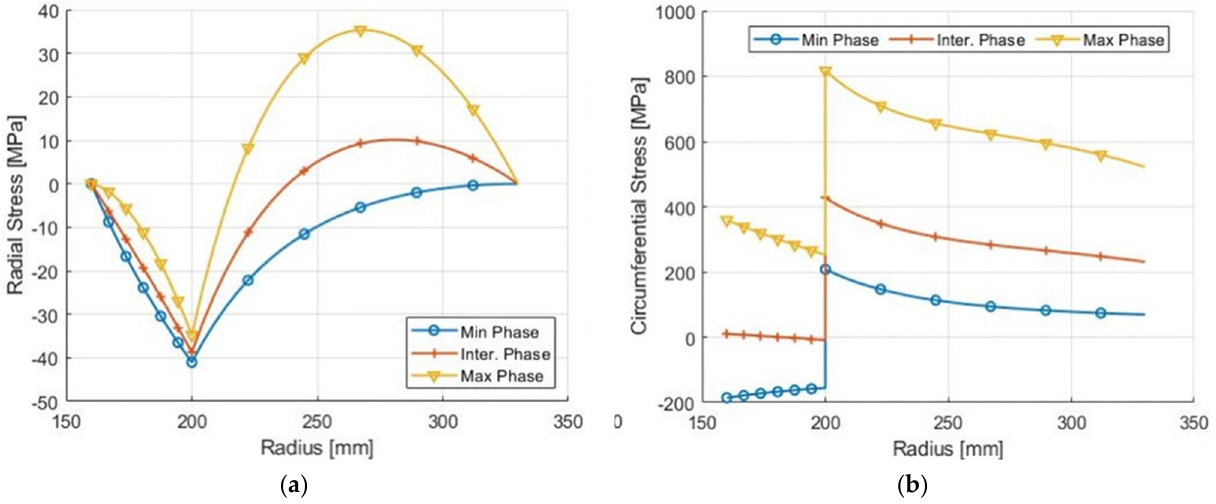
Figure 6. Radial ( a ) and circumferential ( b ) stress results at each velocity on day 1.